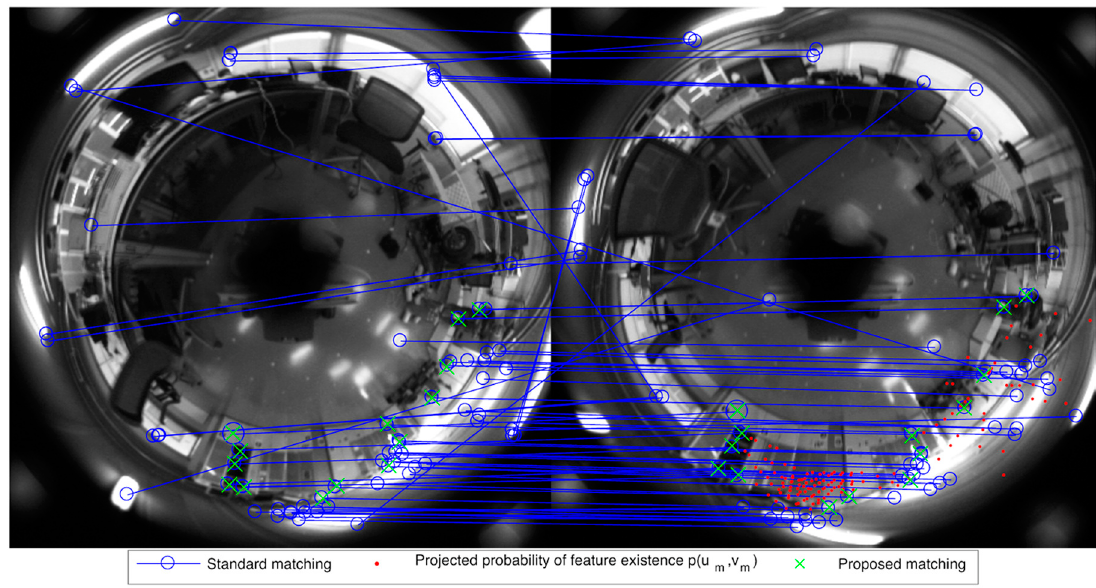
Figure 10. Matching results between images acquired from poses at t and t + 1. Standard matching results are indicated with blue circles, and those obtained with the proposed approach are indicated with green crosses. The pixels associated with the projected probability of feature existence p ( u m , v m ) are indicated with red